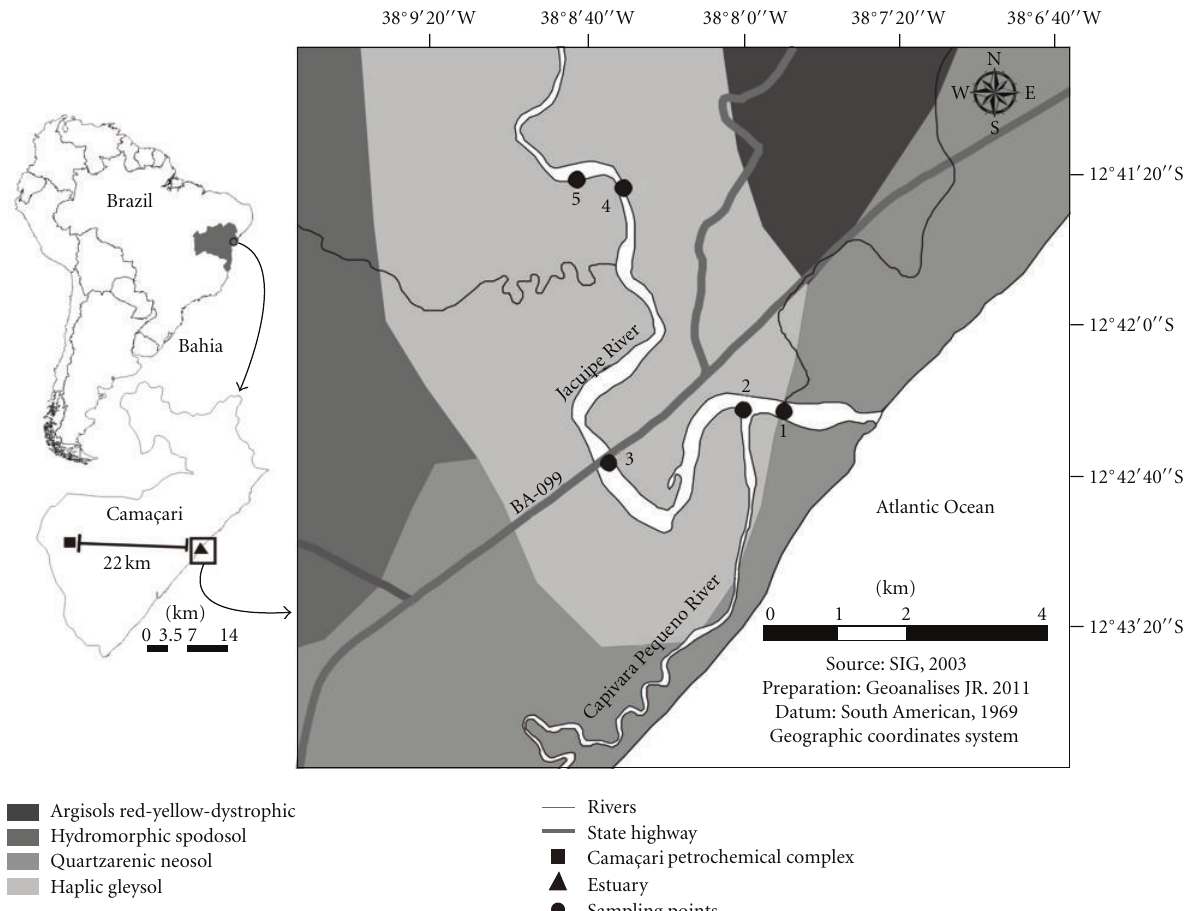
Figure 1: Description of the investigated area with sampling points.